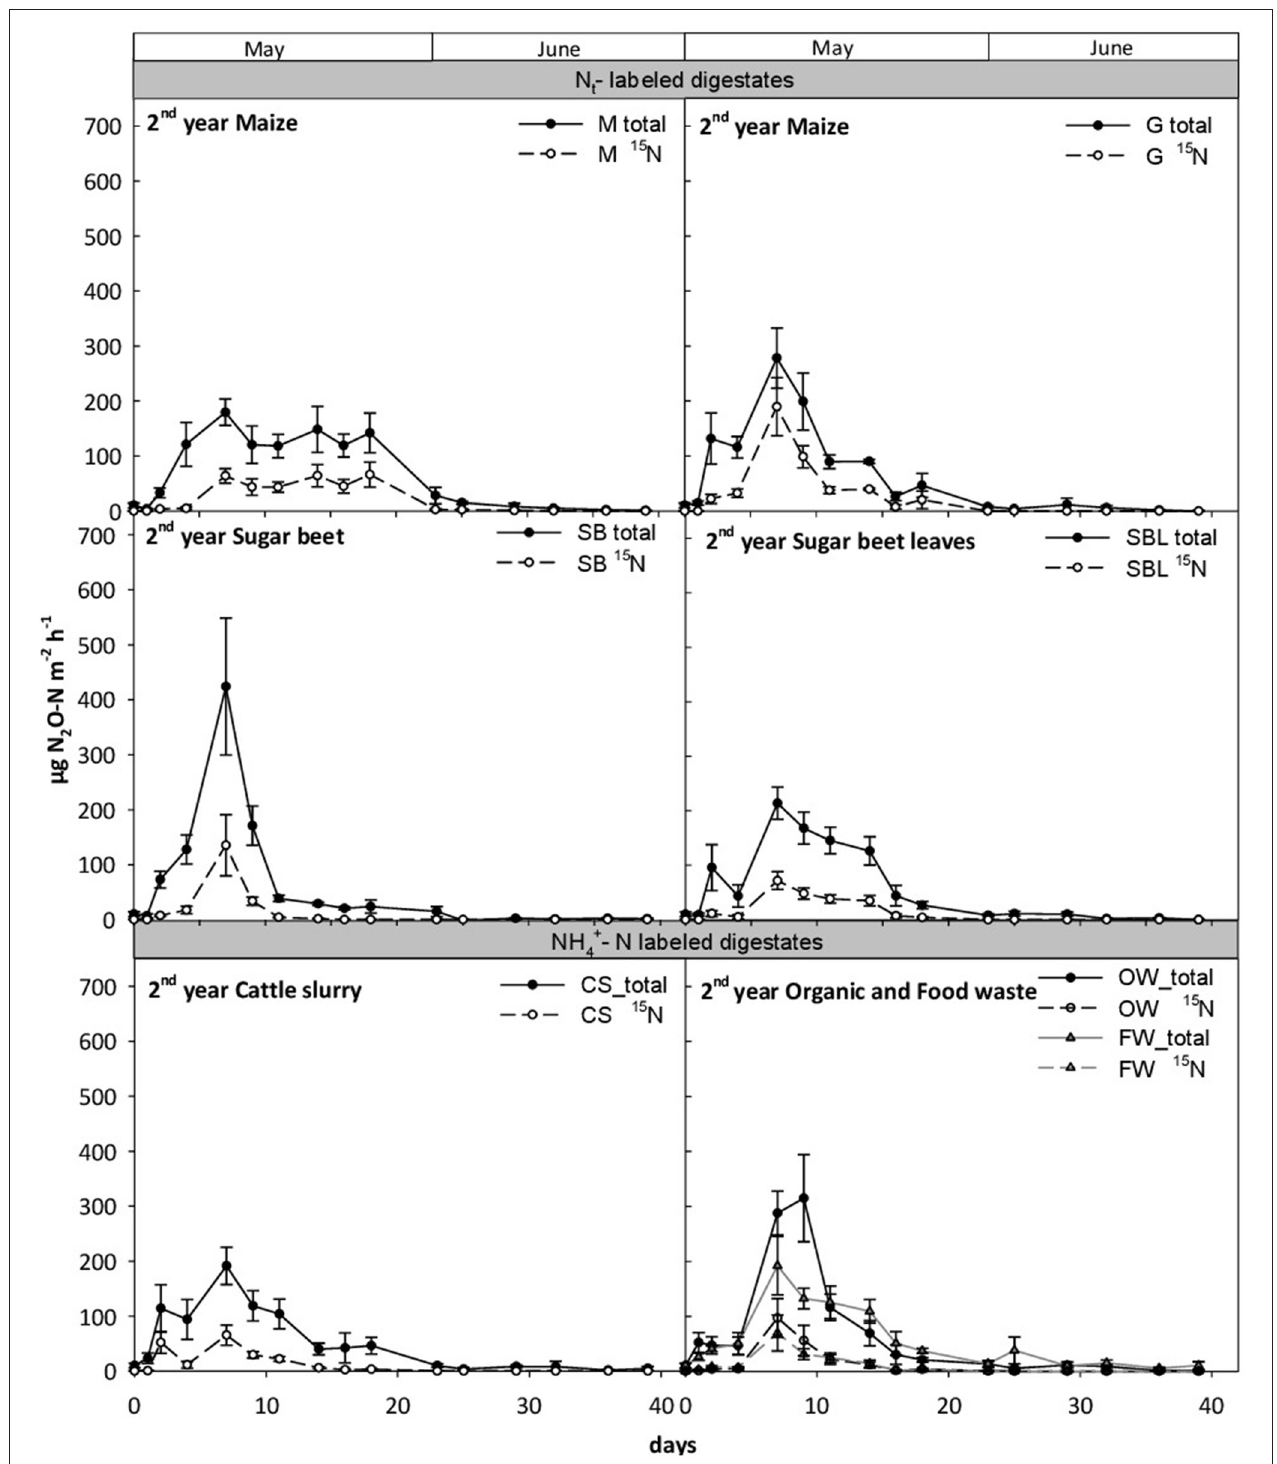
FIGURE 3 | Mean daily N 2 O fluxes (total) and digestate-derived 15 N-N 2 O fluxes ( 15 N) within the 2nd year Digestates from maize (M), grass (G) sugar beet (SB), and sugar beet leaves (SBL) were 15 N t -labeled (mineral and organic N) and digestates based on cattle slurry (CS), organic waste (OW), and food waste (FW), were 15 N-labeled only in the NH + 4 -N pool. Error bars indicate the standard error ( n = 4).